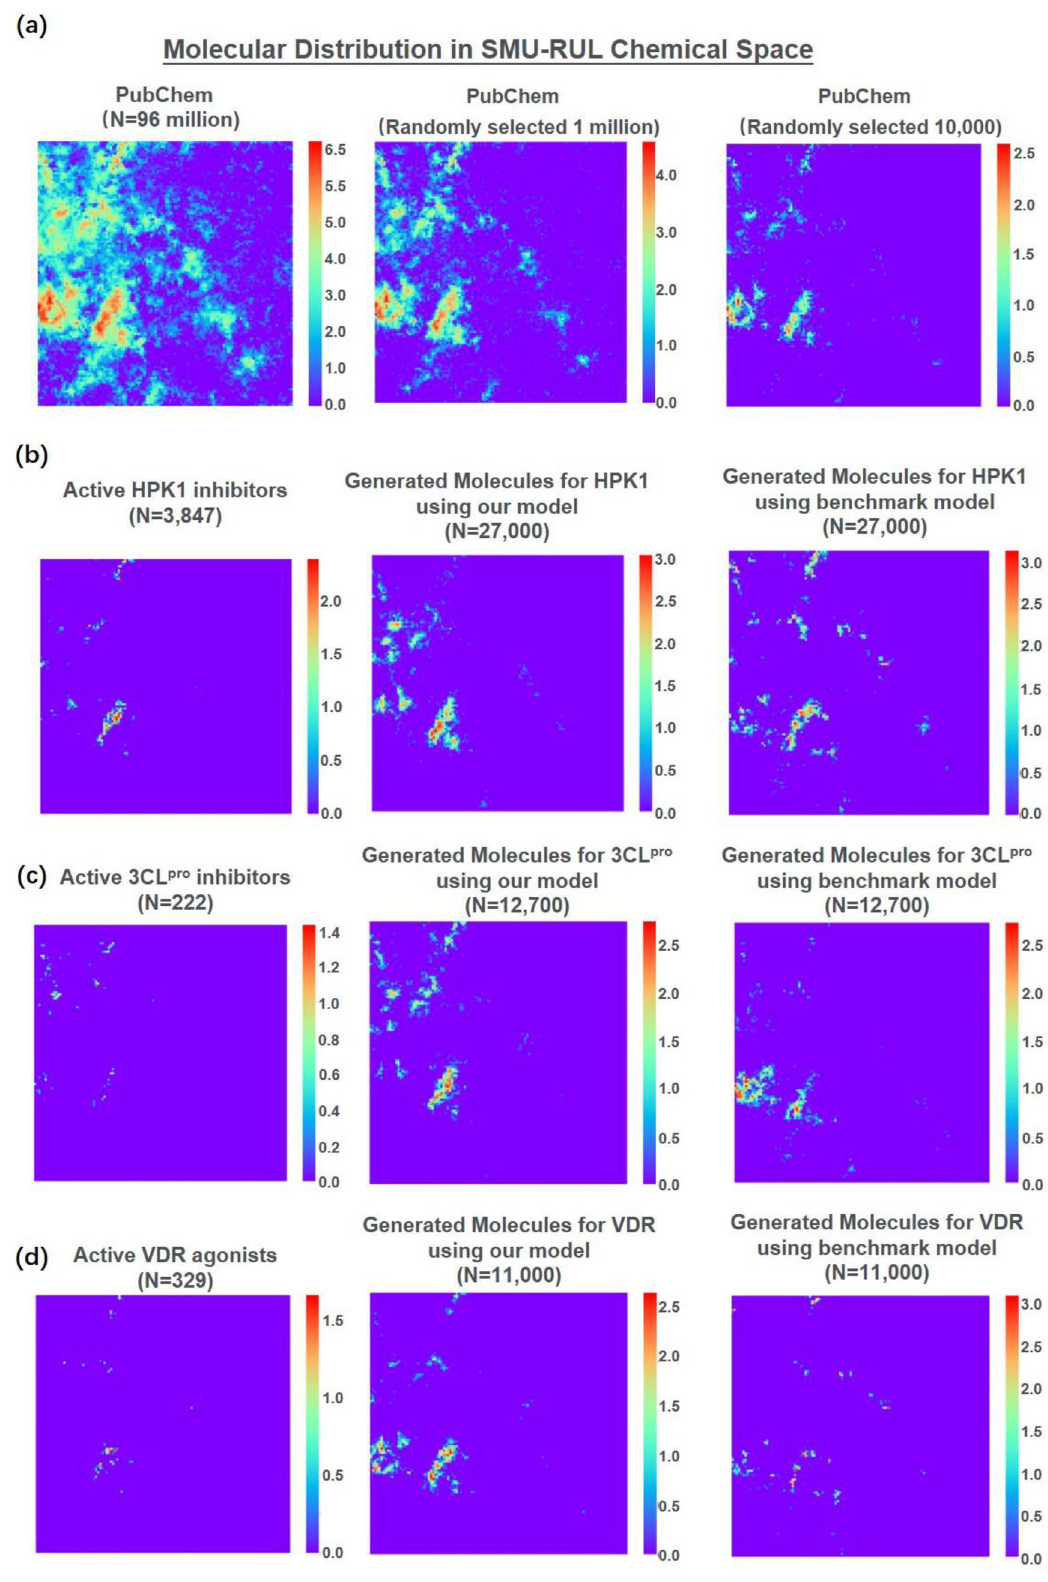
Figure 3. Chemical space distribution of generated molecules and references. A 120 × 120 SOM was created using SMU-RUL 28 compounds. The color indicates the number of molecules on a logarithmic scale. The distributions of molecules from PubChem are listed in panel a. The distributions of reference active compounds and molecules generated using different models for HPK1, 3CL pro , and VDR are listed in panel ( b – d ), respectively. The number of molecules generated by our model is adjusted to match the number that can be generated by the benchmark model within a reasonable time frame. The SMILES of the molecules and their positions in the chemical space are provided in Supplementary material